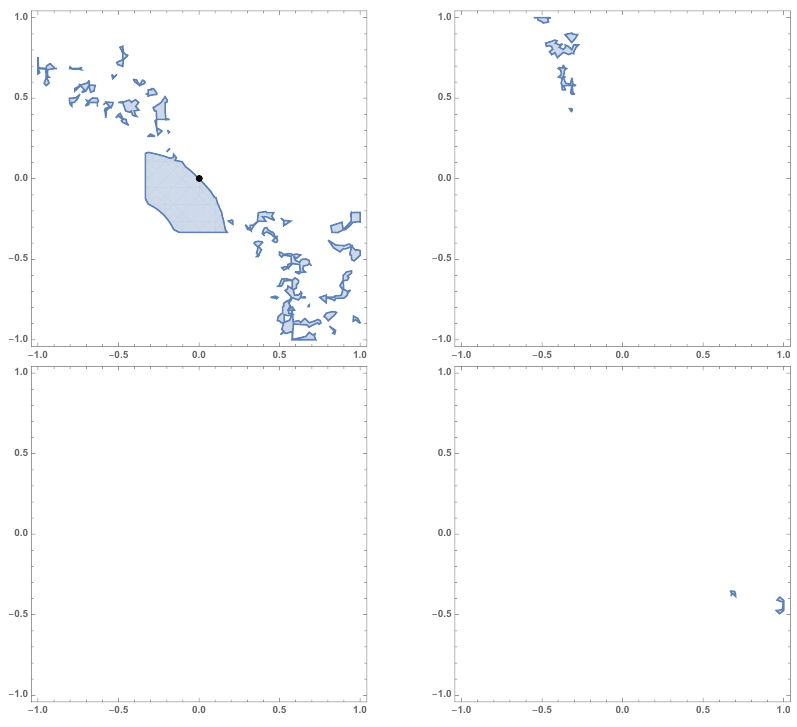
Figure 1 . Positivity range of ( b 1 ; b 2 ) for the H 2 (cid:2) H 2 , H 2 (cid:2) S 2 , S 2 (cid:2) H 2 and S 2 (cid:2) S 2 backgrounds, from the top-left and clockwise. In the H 2 (cid:2) H 2 plot, the black dot at ( b 1 ; b 2 ) = (0 ; 0) corresponds to the AdS 2 solution in